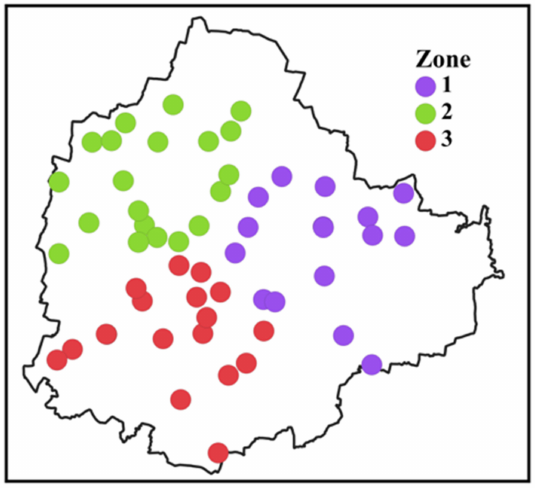
Figure 7. Map showing the three groups of KSNDMC stations. Clustering was performed by k-means, where grouping was carried out based on the coordinates and elevation.